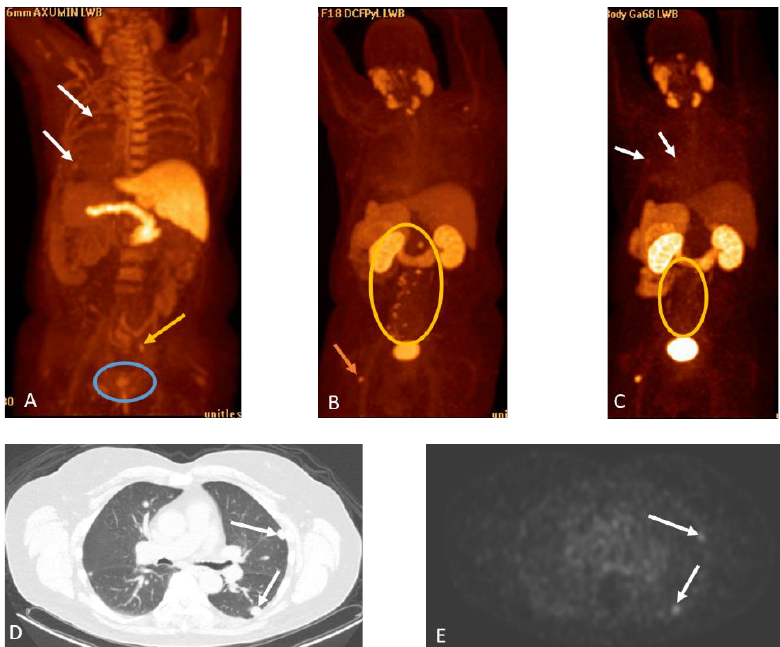
Figure 21. Same patient as Figure 10. Axumin PET image shows physiologic uptake within the liver with more intense uptake in the right hepatic lobe, suggesting metastatic disease. The heterogene- ous physiologic uptake pattern in the liver may make identifying small hepatic metastases challeng- ing.